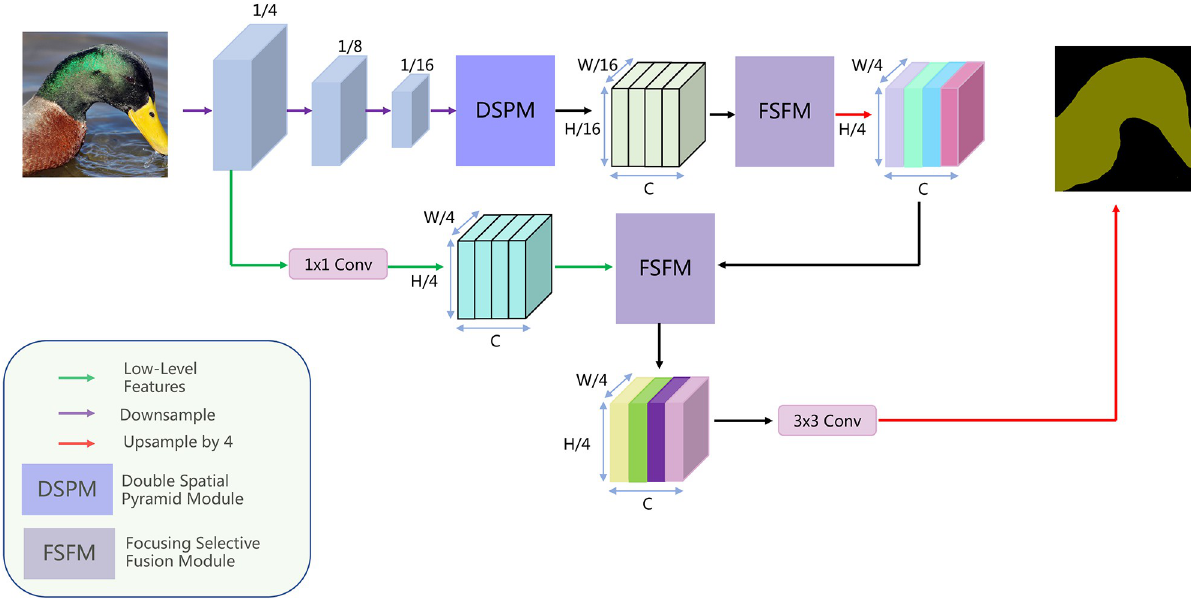
Fig 1. The pipeline of Multi-scale Feature Enhanced Adaptive Fusion Network